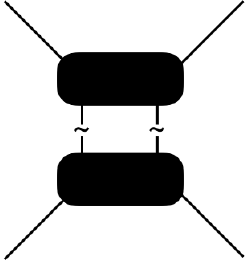
Figure 2 . Discontinuity across branch cut for four point